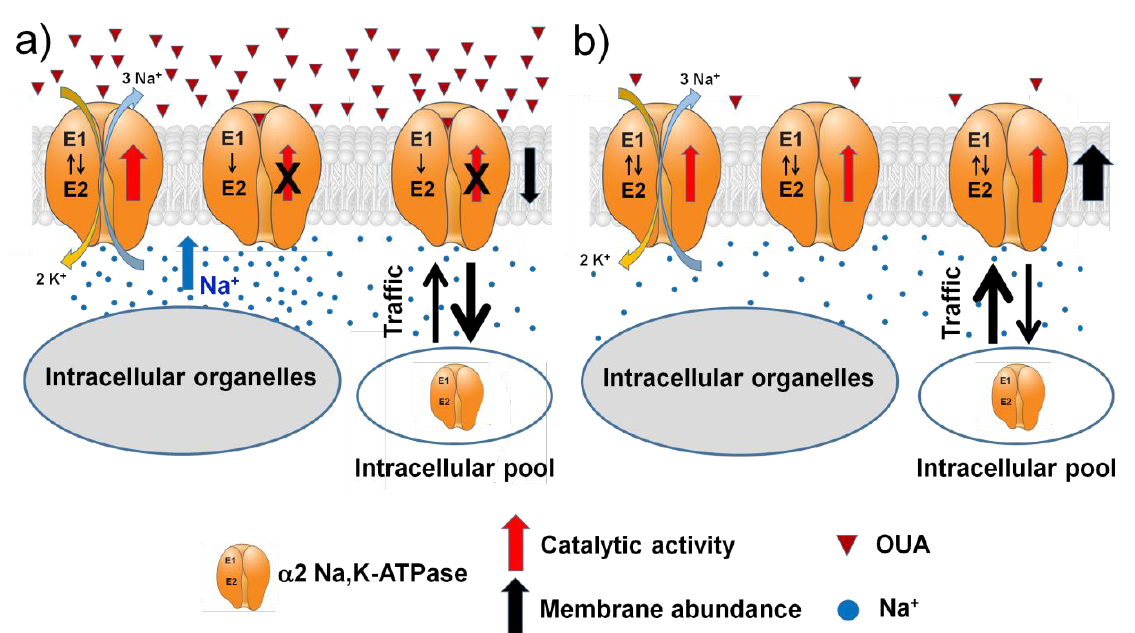
Figure 10. A schematic presentation of the dynamic regulation of α2 Na,K-ATPase transport activity by relatively high ( a ) and low ( b ) concentrations of circulating ouabain (see the text).